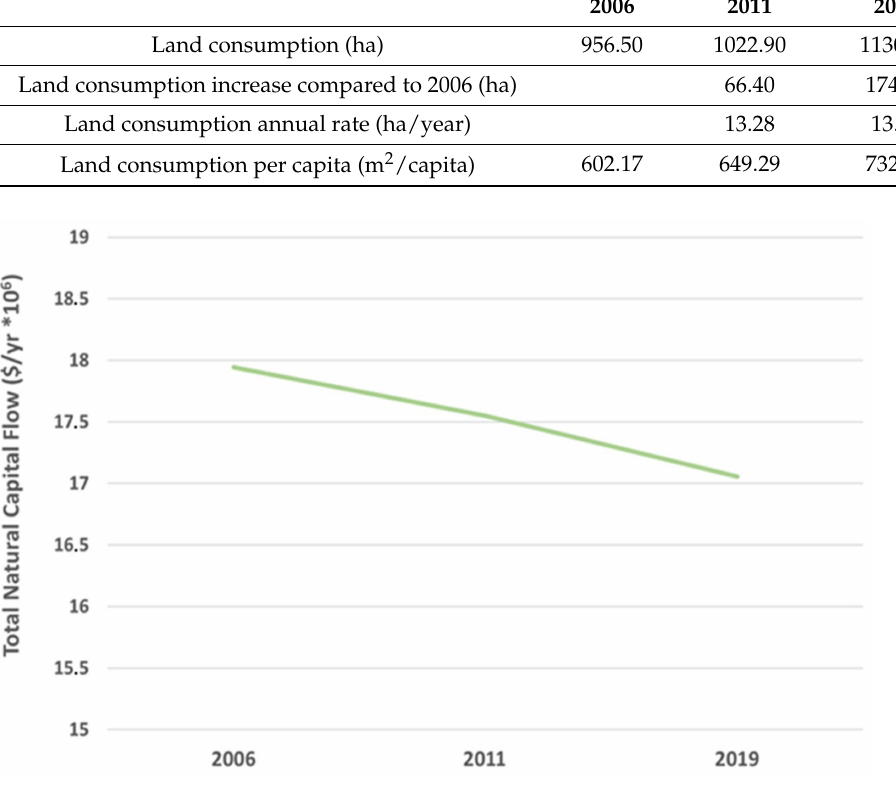
Figure 4. Trend of natural capital flow in ($/year) for the years 2006, 2011,